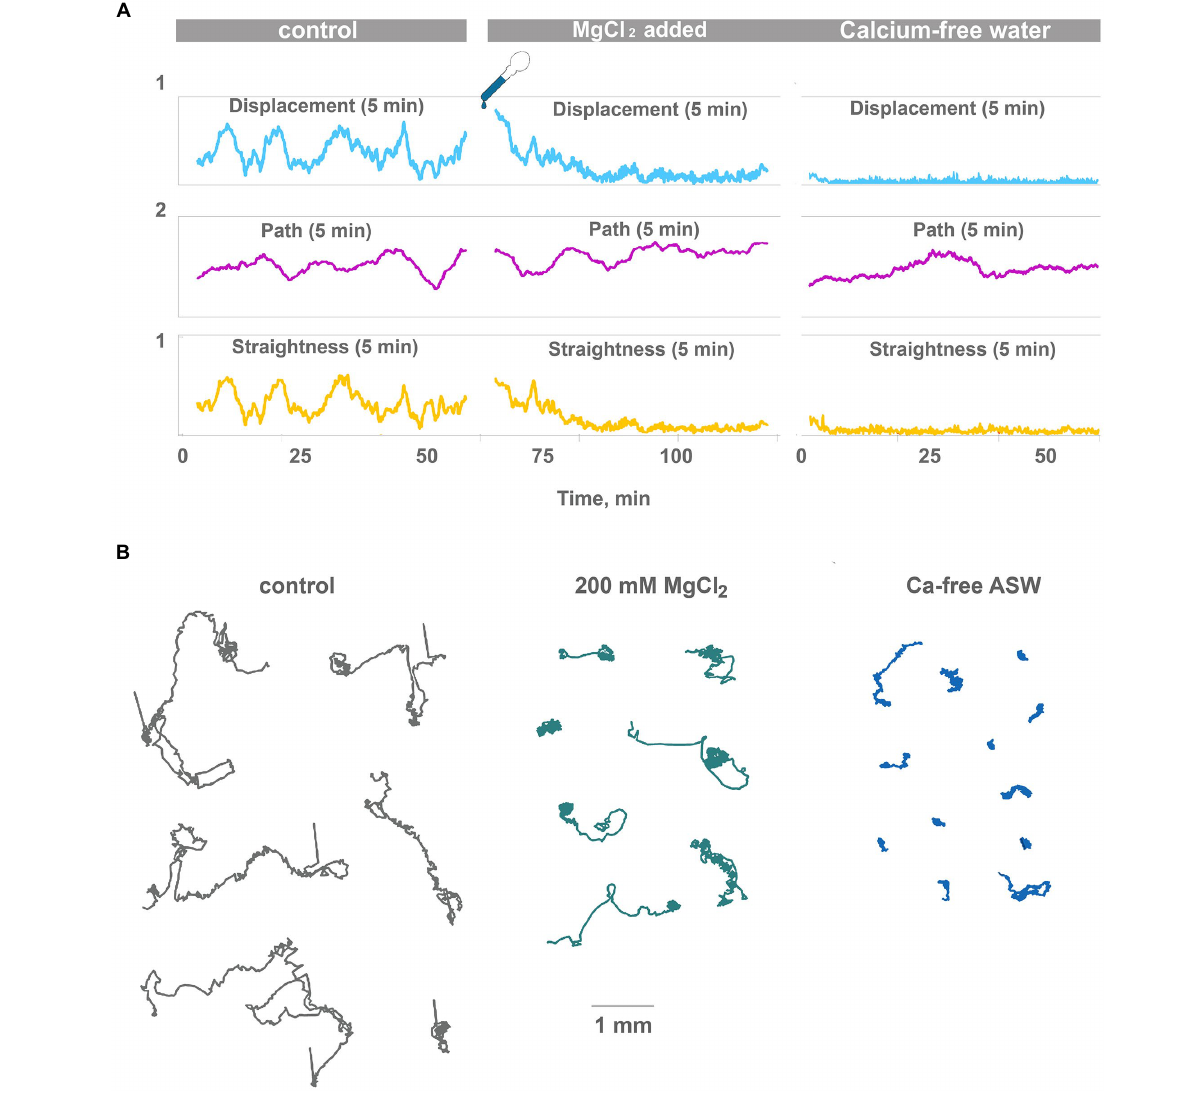
FIGURE 3 High Mg 2+ or low Ca 2+ disrupts coherent locomotion and oscillations. (A) Representative plot of displacement, track length, and track straightness (displacement/length ratio) for 5 min periods for a single animal observed for 120 min on a clean Petri dish in normal seawater and after the addition of 200 mM MgCl 2 (corrected for osmolarity). Oscillations of straightness and displacement present in control conditions (compare Figure 2A) and gradually disappear after 20 min in 200 mM MgCl 2 . However, the 5-min path is unchanged. Therefore, animals continue ciliated locomotion but lose the ability to maintain one direction. Representative plot of displacement, track length, and track straightness for 5 min periods for single animal observed for 60 min in low-Ca seawater. Displacement and straightness are close to zero immediately after a drop in Ca 2+ concentration, but track length is similar to control. Coherent directed movement is quickly lost, compared to 20 min transition period in 200 mM MgCl 2 . (B) Tracks of Trichoplax in normal seawater (45 mM Mg 2+ , 10 mM Ca 2+ as control), after adding 200 mM MgCl 2 , and in low-Ca seawater (1 mM Ca 2+ ), respectively. Tracks were recorded for 60